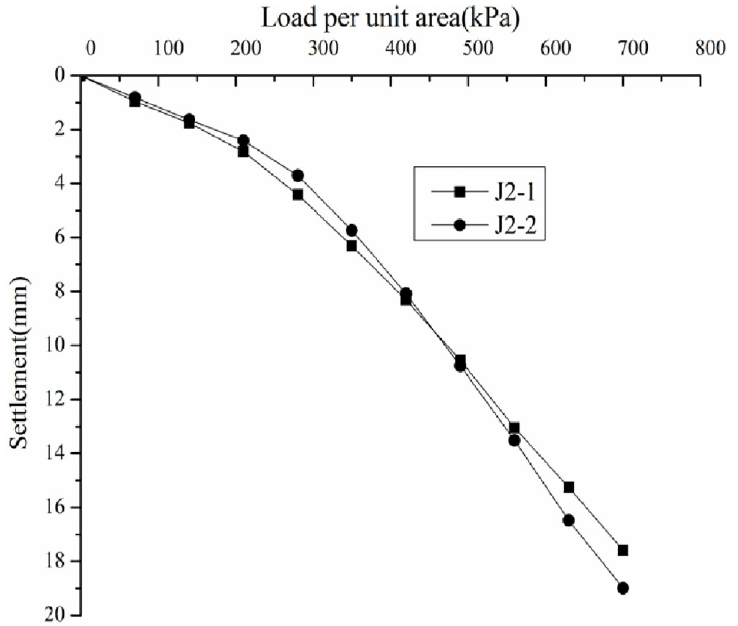
Fig 15. Load-–settlement curves for the plate loading tests of J2.